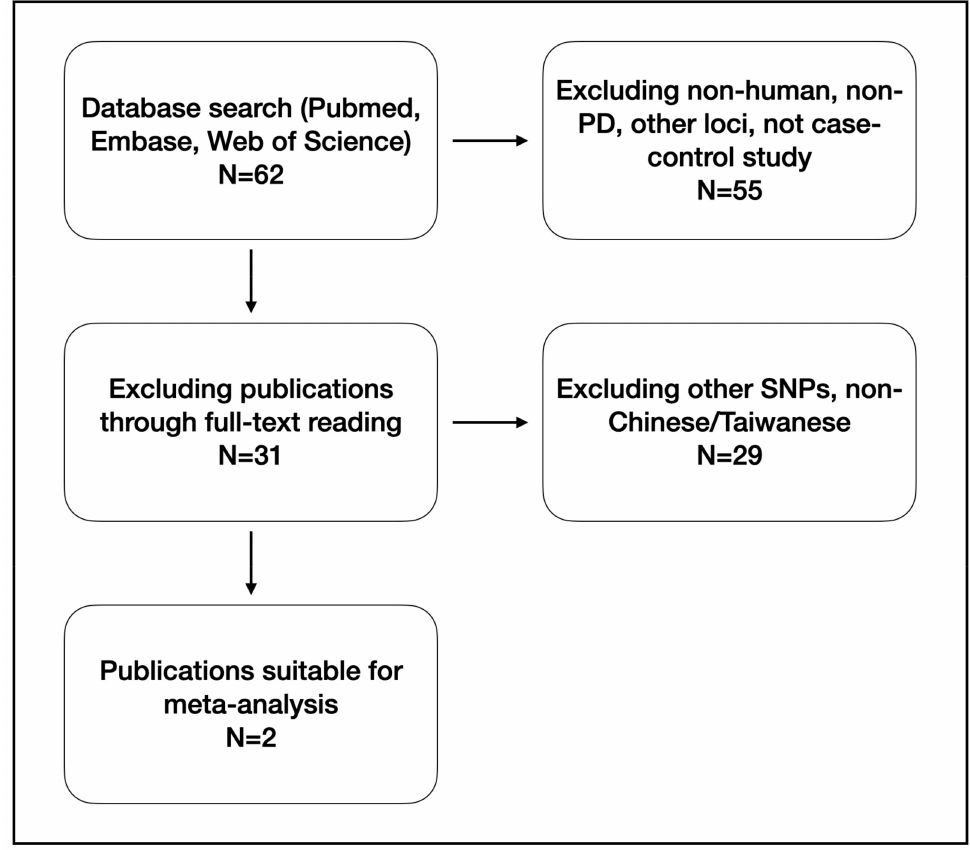
Figure 1. Literature search and